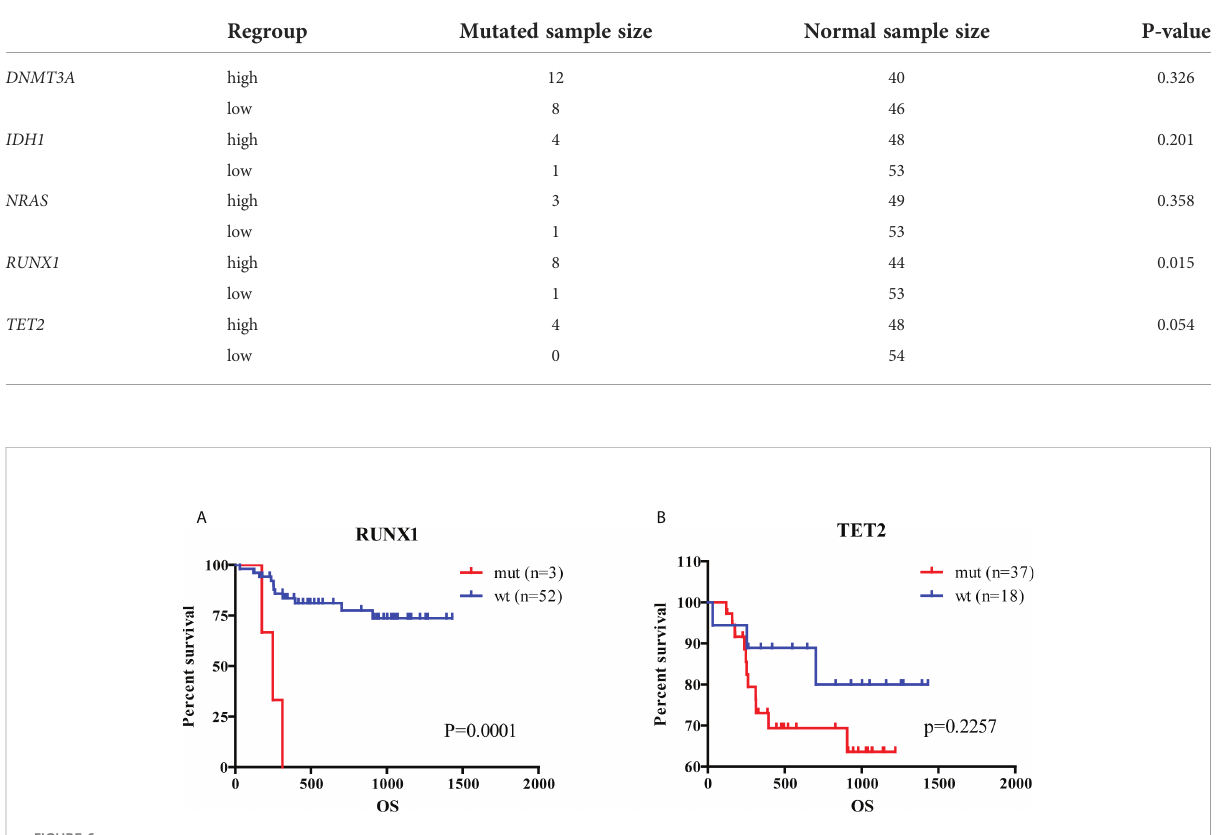
TABLE 2 Results of Chi-square test to 5 common mutated genes based on regrouping LASSO model in TCGA-AML database.